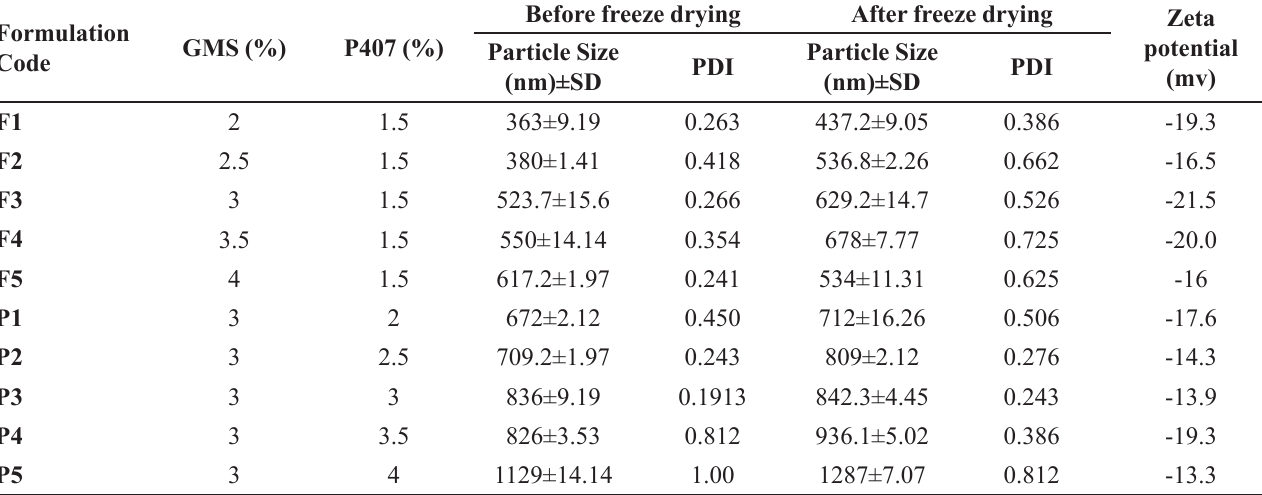
TABLE I - Composition and characterization of the prepared SLNs